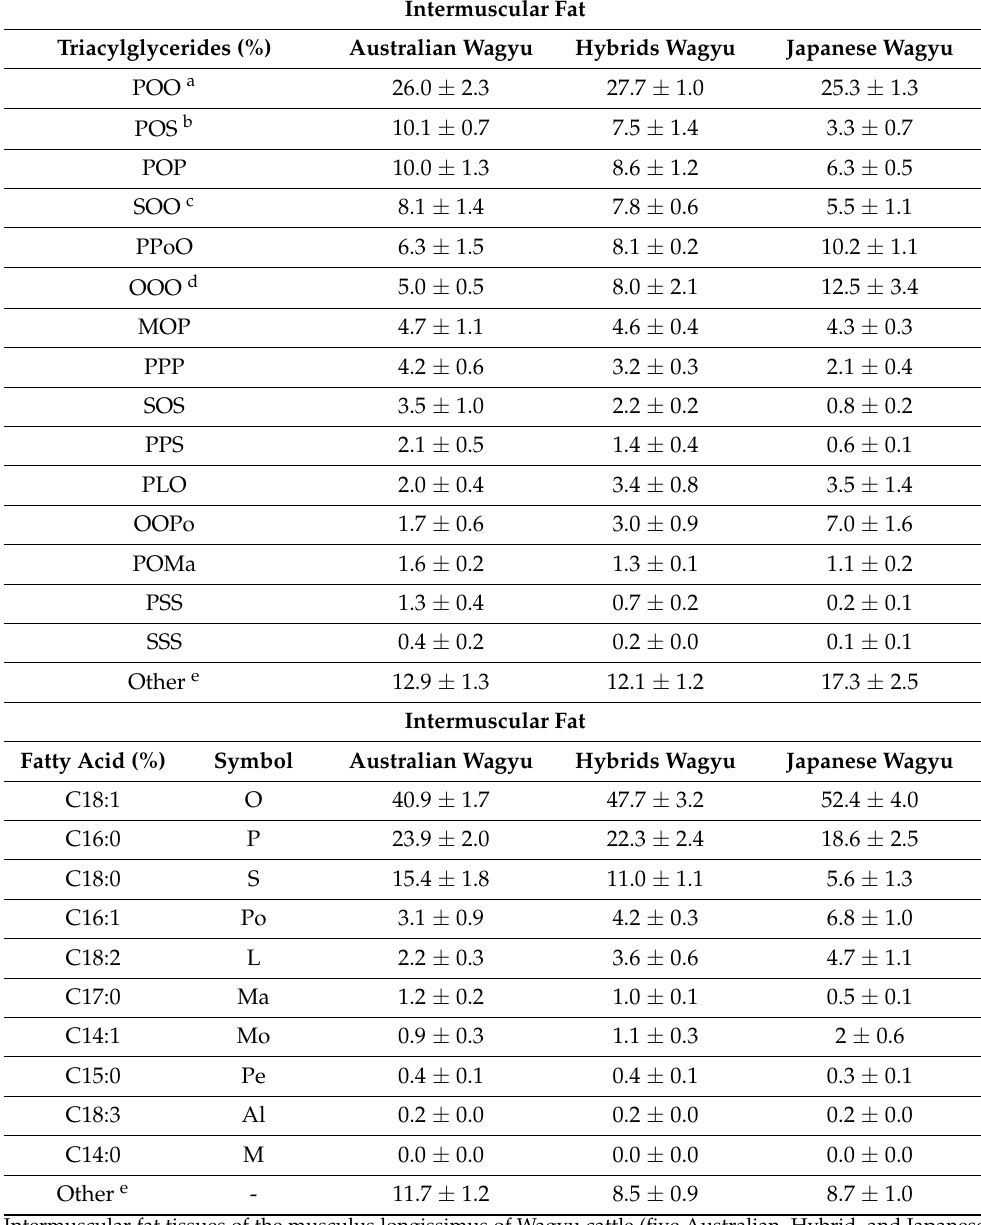
Table 3. TGs and fatty acids in the intermuscular fat of each Wagyu